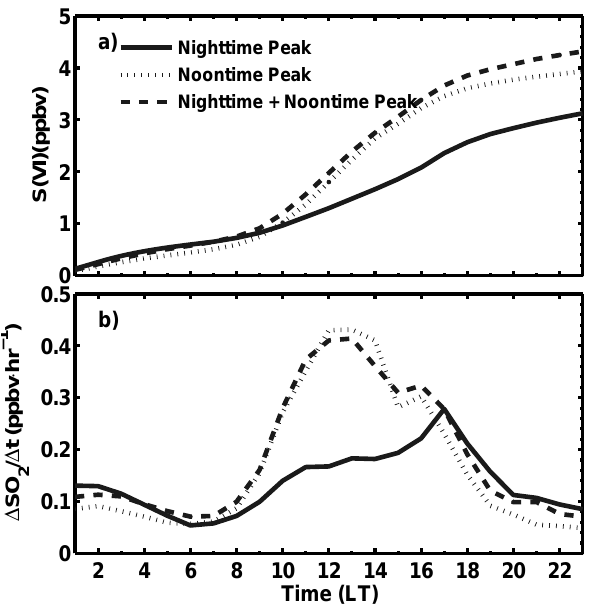
Figure 7 Simulated gas phase oxidized SO 2 a) amount and b) oxidation rates based on the three 2 Figure 7. Simulated gas phase oxidized SO 2 (a) amount and (b) ox- idation rates based on the three characteristic SO 2 diurnal variation characteristic SO 2 diurnal variation patterns in Wuqing during autumn 2009. 3 patterns in Wuqing during autumn 2009. Table 5. Estimated SO 2 aqueous oxidation amount for the three dif- ferent SO 2 diurnal variation patterns, the occurrence frequency (of the three groups) weighting averaged value and the relative increase compared to the nighttime peak case.